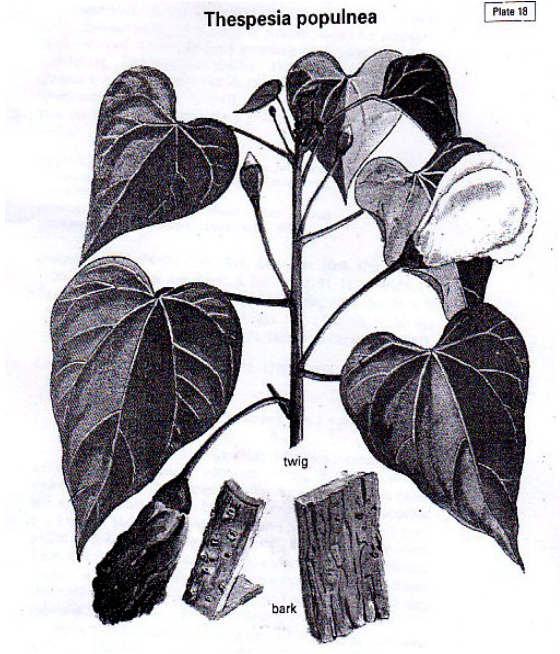
Figure 2. Thespesia Populnea